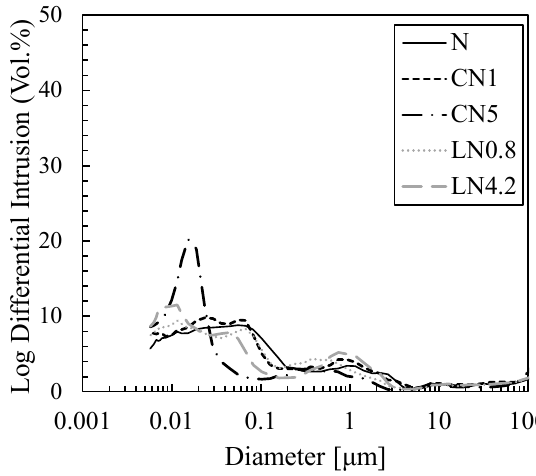
Figure 12. Cumulative void size distribution (1 day).